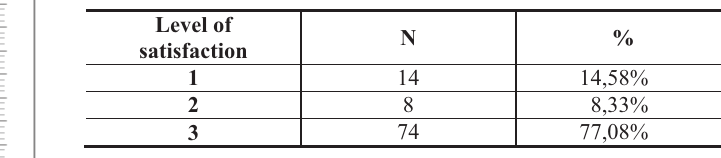
Table 4: Frequency distribution for overall job